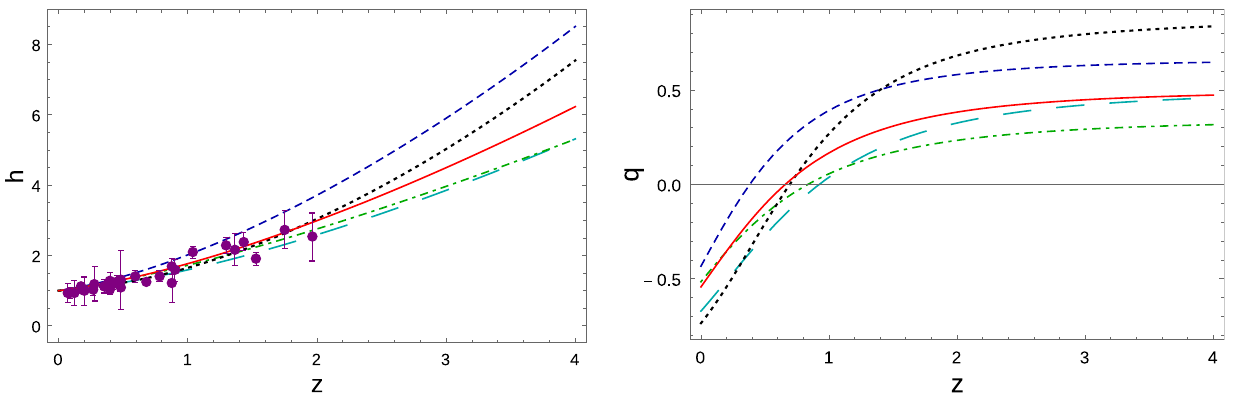
¯ γ = 0 . 15 (dot-dashed curve), and ¯ β = 0 . 11 and ¯ γ = − 0 . 32 (dotted curve), respectively. For the Hubble parameter, we have also plotted the observational data together with their errors [168–176]. The (cid:7) CDM curve is depicted as a red solid